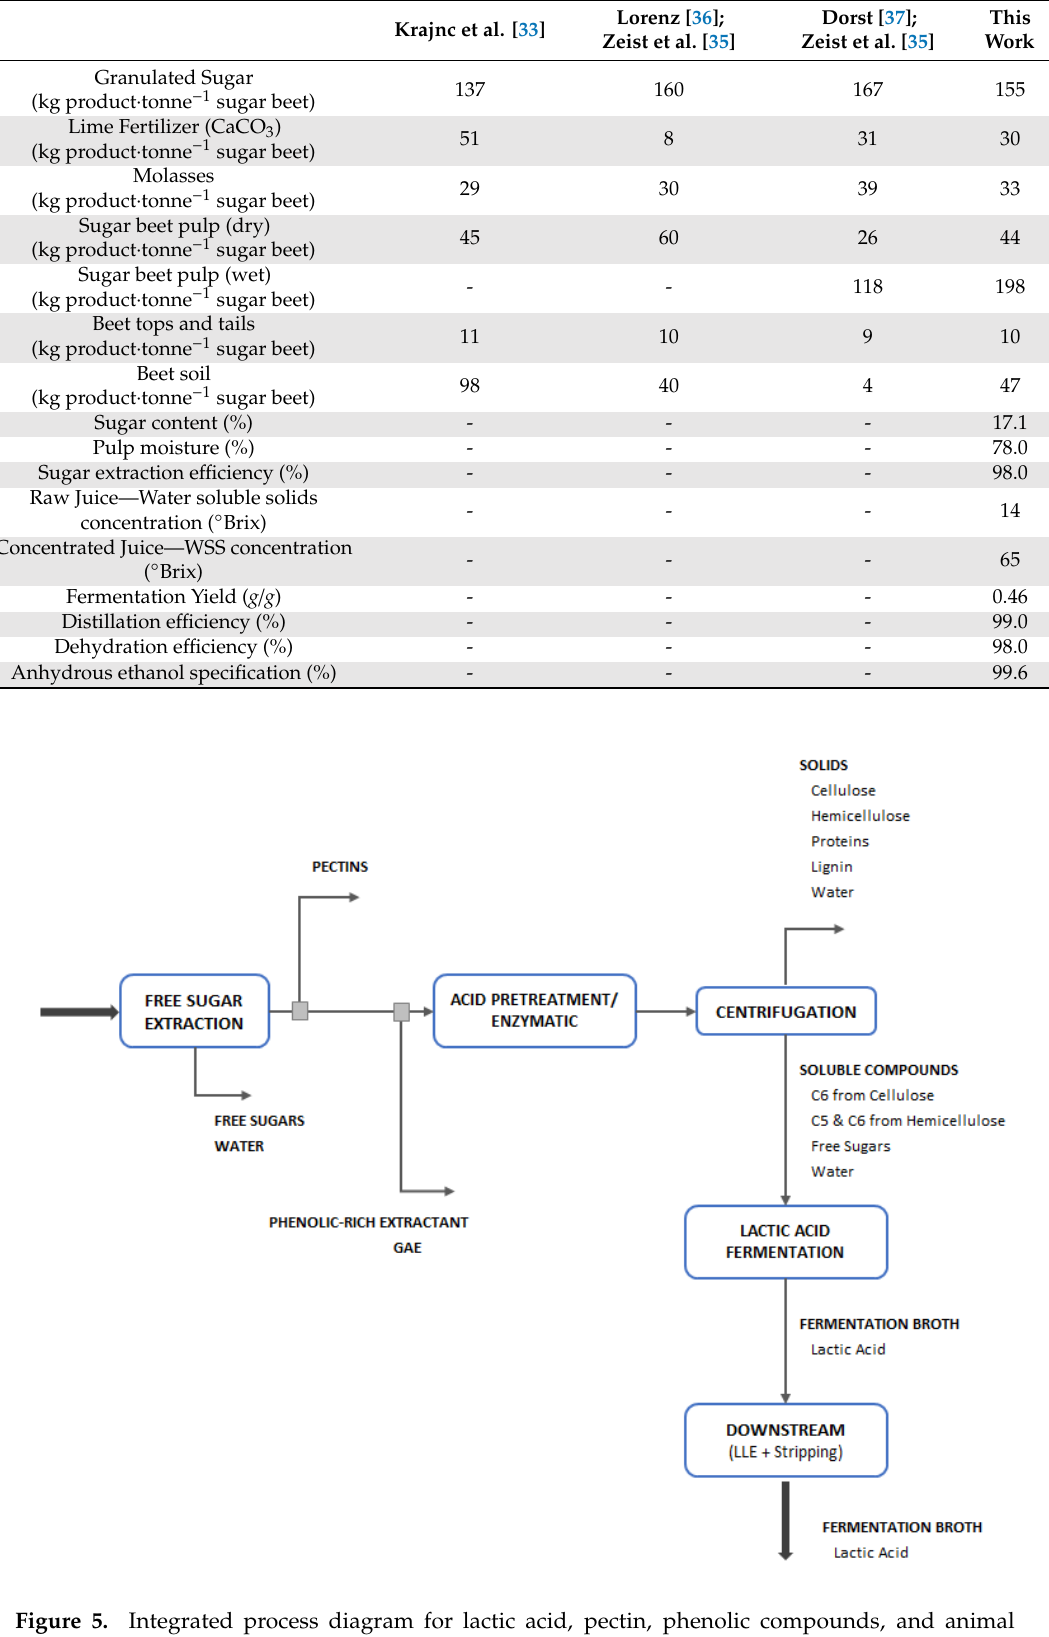
Figure 5. Integrated process diagram for lactic acid, pectin, phenolic compounds, and animal feed production.